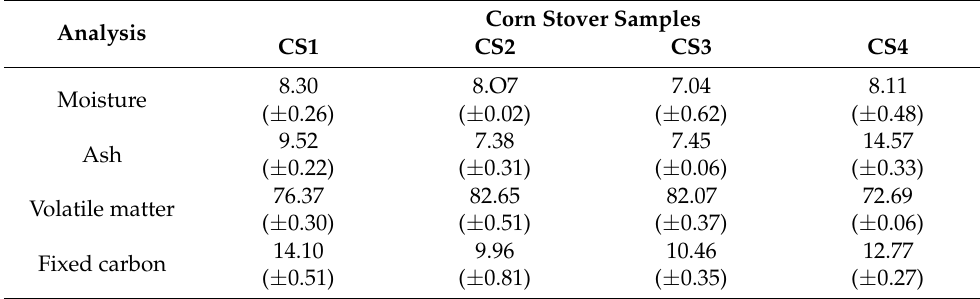
Table 2. Proximate analysis of biomass of corn stubble